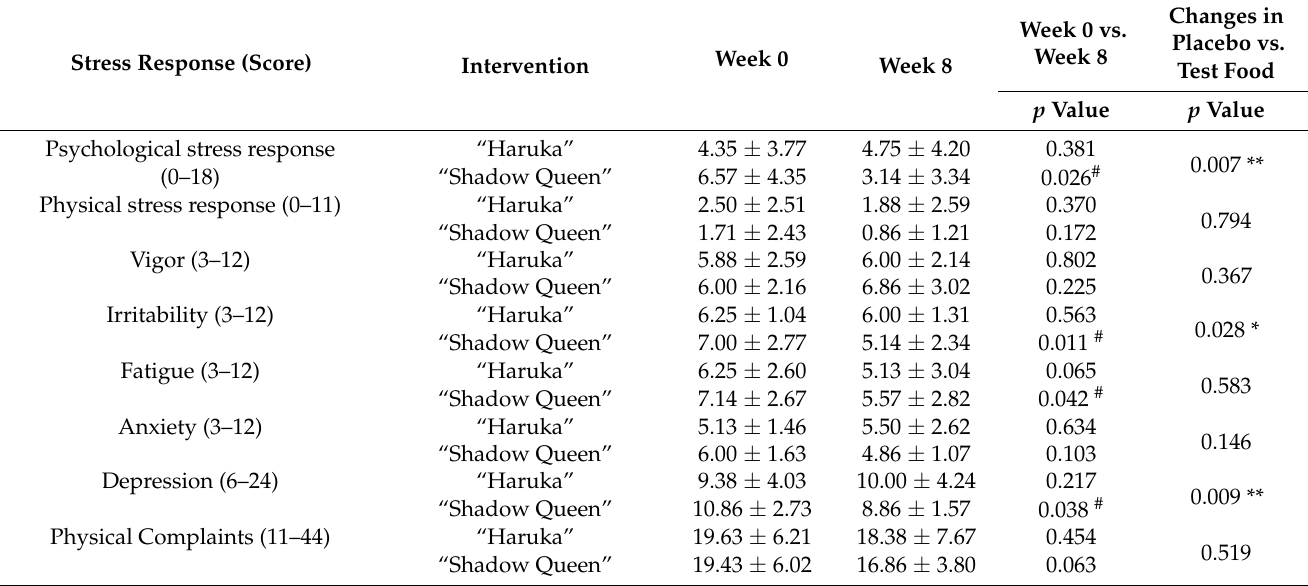
Table 3. Changes in stress response scores as a secondary outcome after taking “Shadow Queen” and